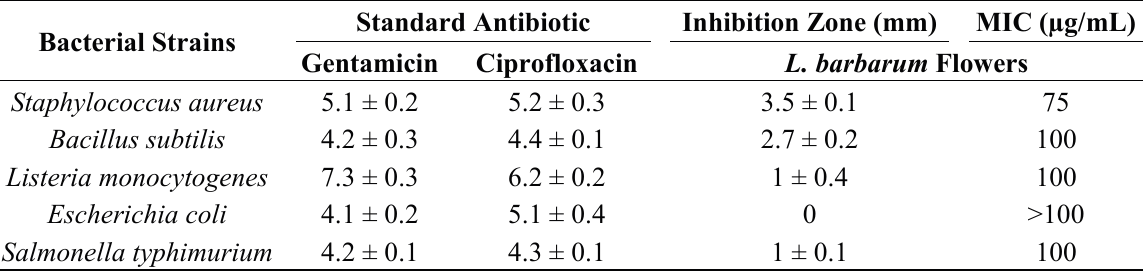
Table 4. Antibacterial activity and minimal inhibitory concentration of L. barbarum flower extract. Standard Antibiotic Inhibition Zone (mm) MIC (µg/mL) Bacterial Strains Gentamicin Ciprofloxacin L. barbarum Flowers Staphylococcus aureus 5.1 ± 0.2 Listeria